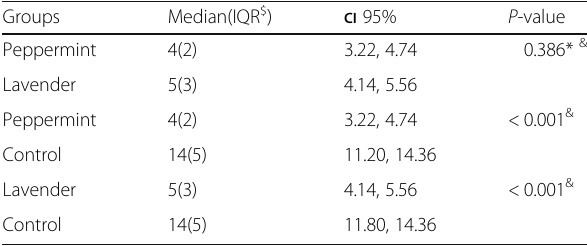
Table 3 Comparing the study groups in terms of sleep quality after